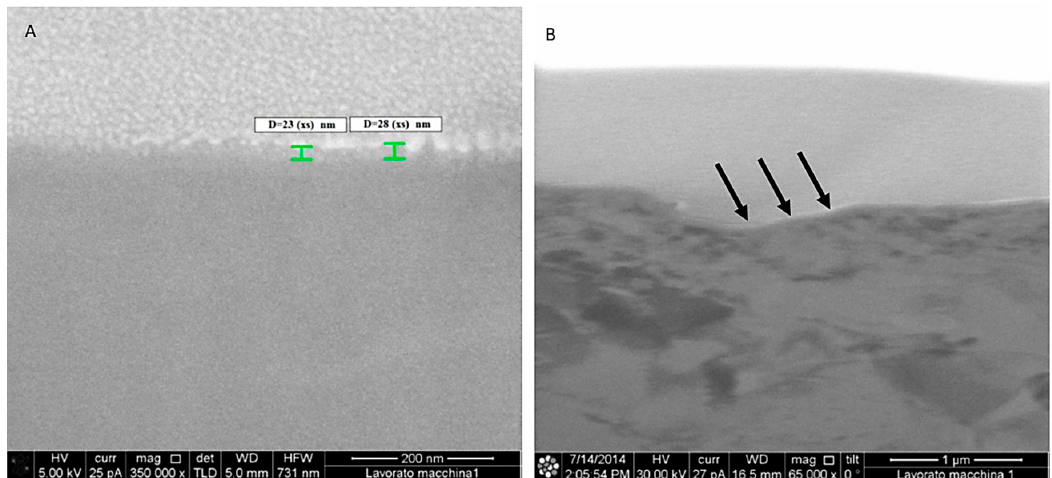
Figure 3. ( A ) Thickness of the oxidation layer of a machined implant. ( B ) Thickness of the oxidation layer (arrows).